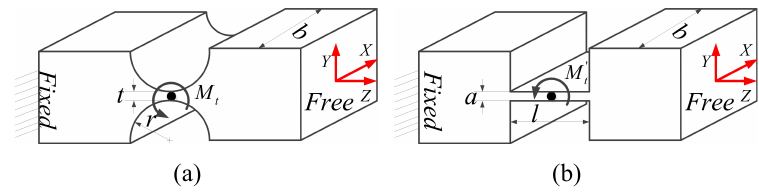
Figure 6. The flexure hinges: (a) the circular notched hinge; (b) the prismatic beam.